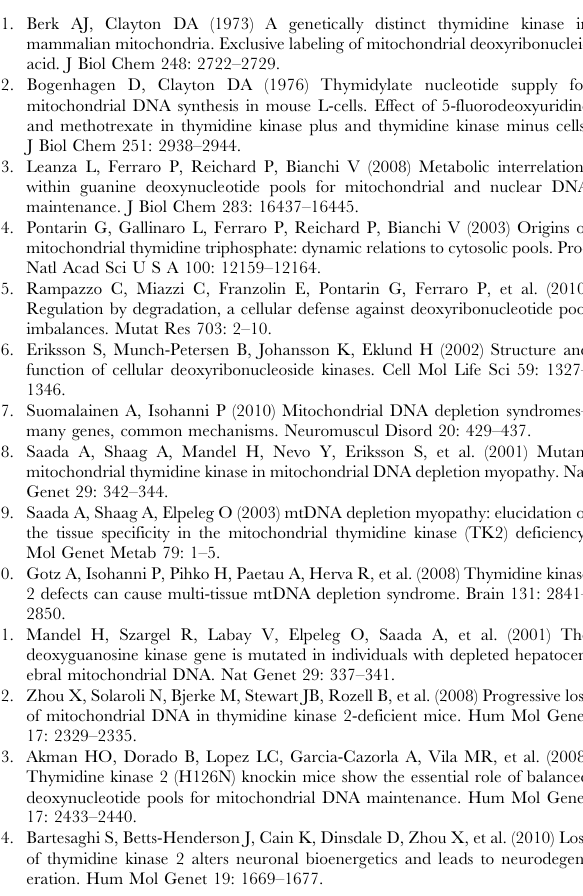
muscle of 11 days-old Tk2 knockout ( Tk2 2 / 2 ) mice. Table S1 Global gene expression variation in skeletal muscle (SM) and heart (HE) harvested from 11 days old Tk2 knockout mice (TK2-) comparing to wild-type mice (WT) at the same age. Fold-changes and P -values obtained in the microarray analysis performed are indicated for each gene. ns indicates that the gene was not significantly up- or down-regulated in the